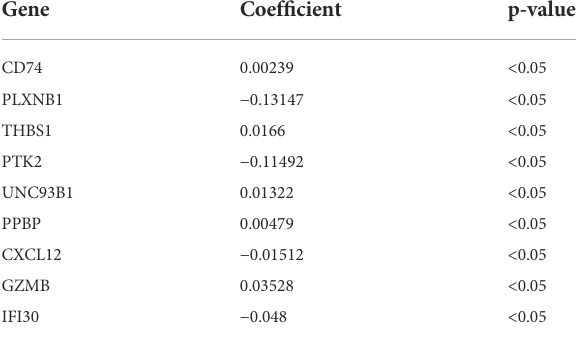
TABLE 3 Coef fi cient of 9 immune-related prognostic